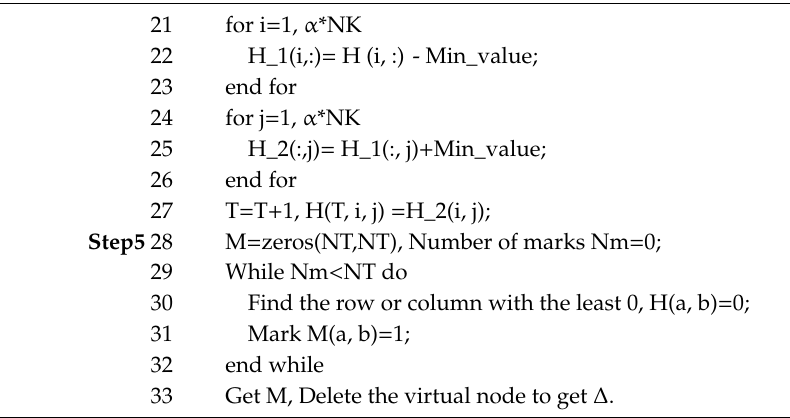
Algorithm 2: Channel assignment based on Hungarian algorithm